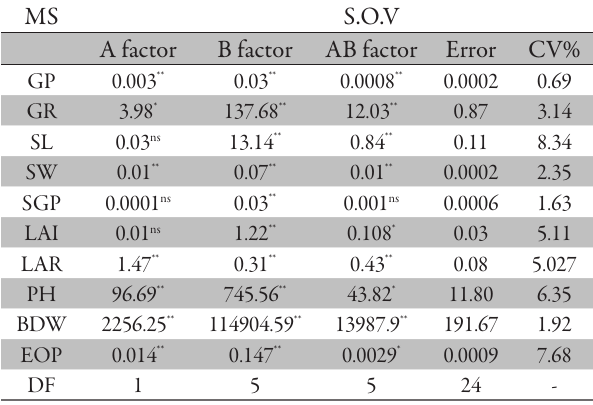
Tab. 1. Mean squares of two landraces of lemon balm